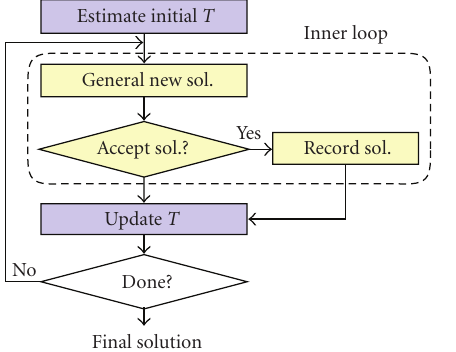
Figure 1: Block diagram of the classic simulated annealing (SA).